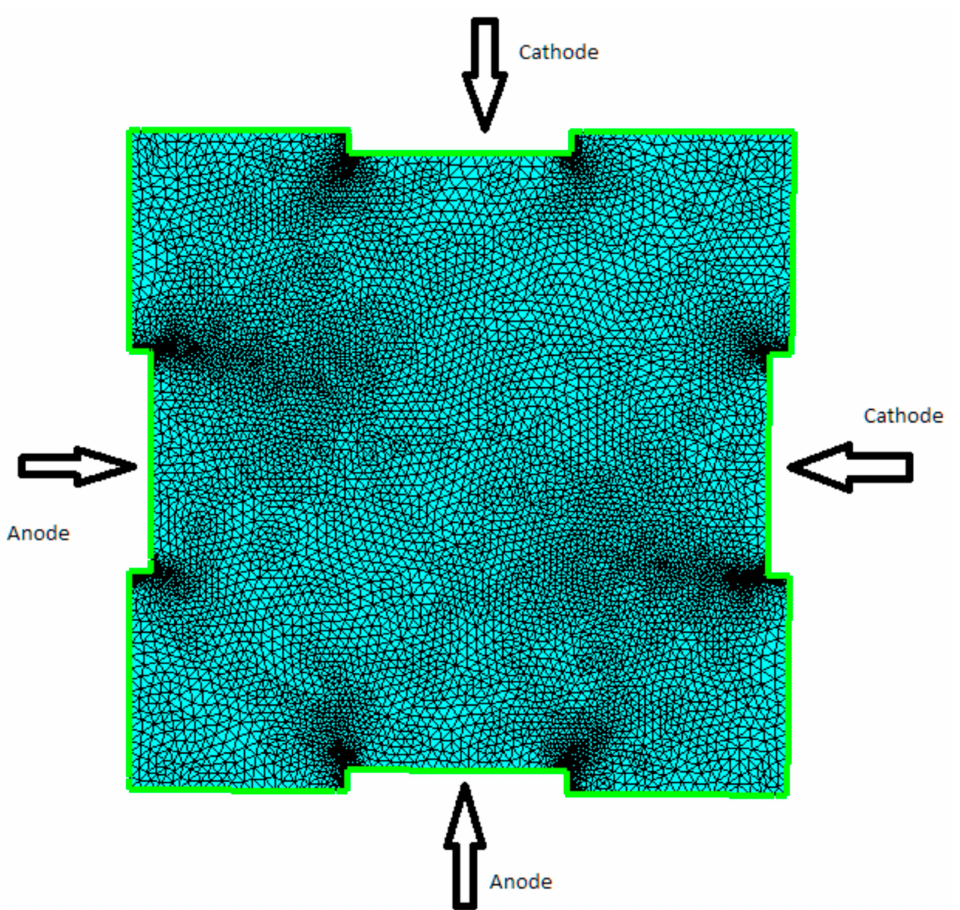
Figure 11. The boundary conditions